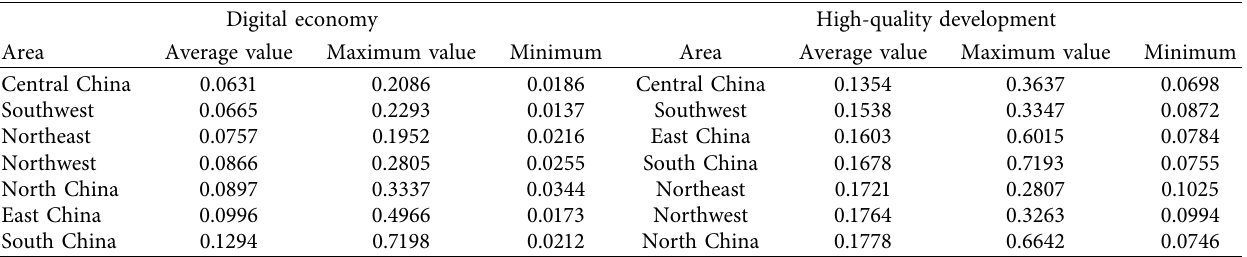
Table 5: Descriptive statistics of comprehensive scores of digital economy and high-quality development in seven regions. Digital